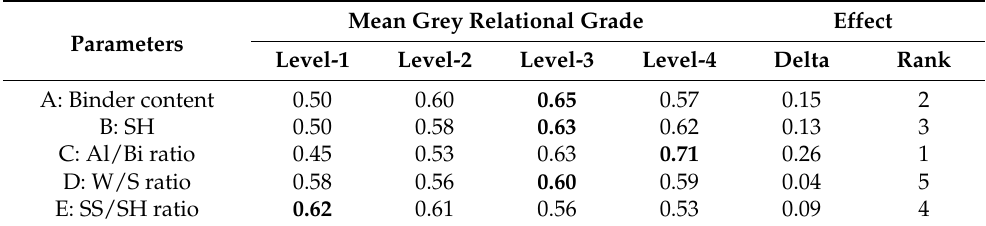
Table 6. Main effect table for the grey relational grade.